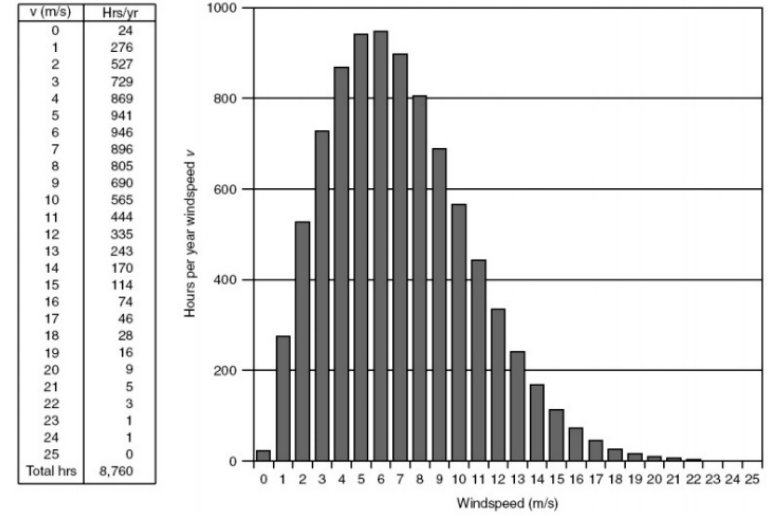
Figure 7. Yearly wind speed variation.